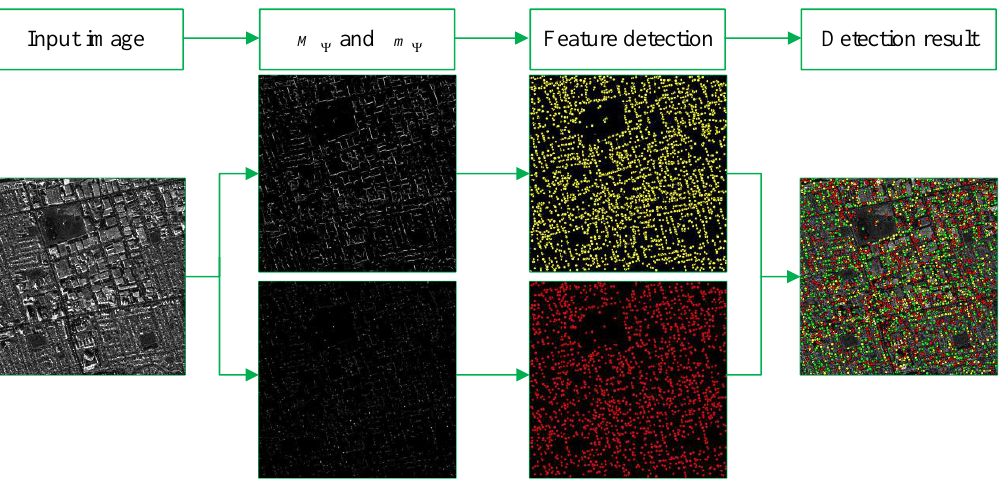
Figure 3. Flowchart of feature detection.